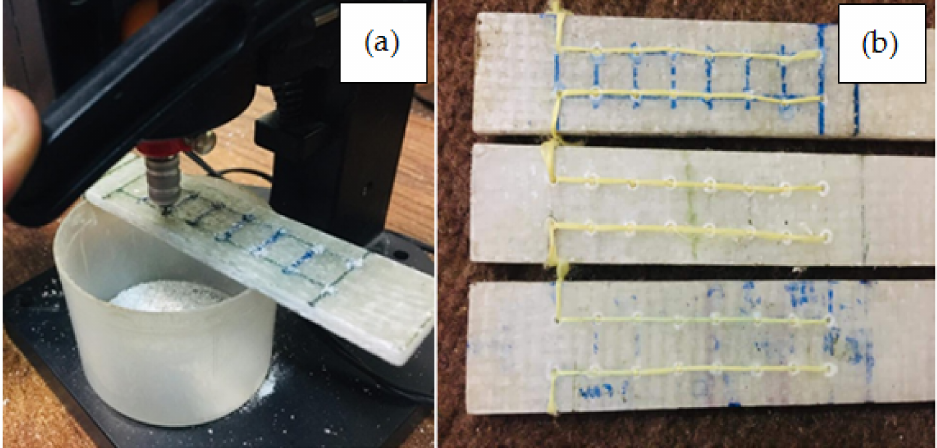
Figure 2. ( a ) Kevlar thread and drilling of the specimen ( b ) stitched double cantilever beam